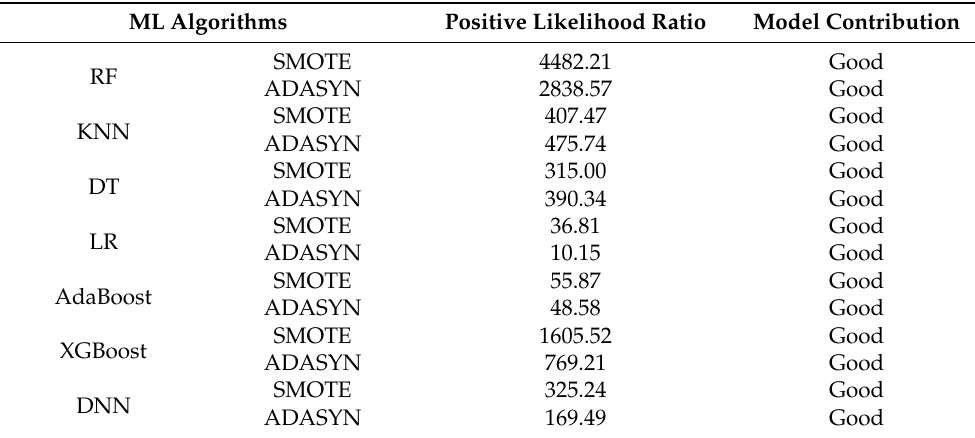
Table 9. Positive Likelihood Ratio based on resampling approach 1.